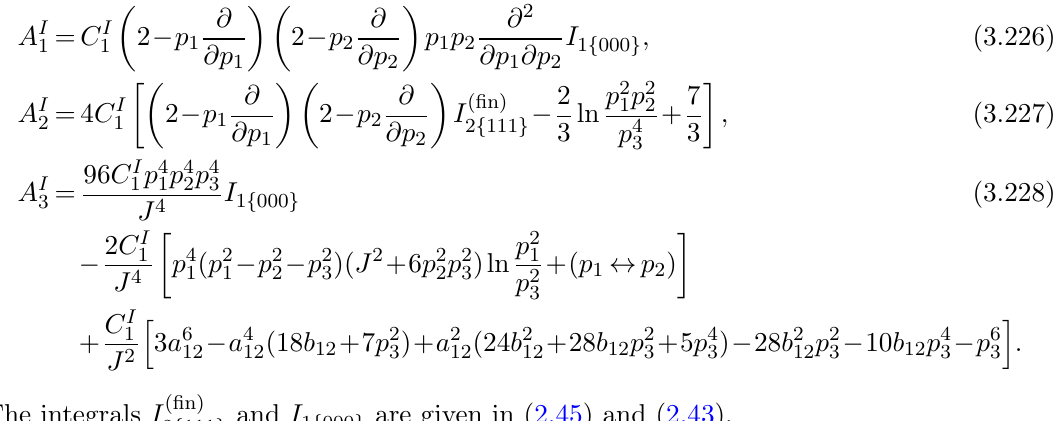
and I are given in (2.45) and (2.43). 1 f 000 g 2 f 111 g